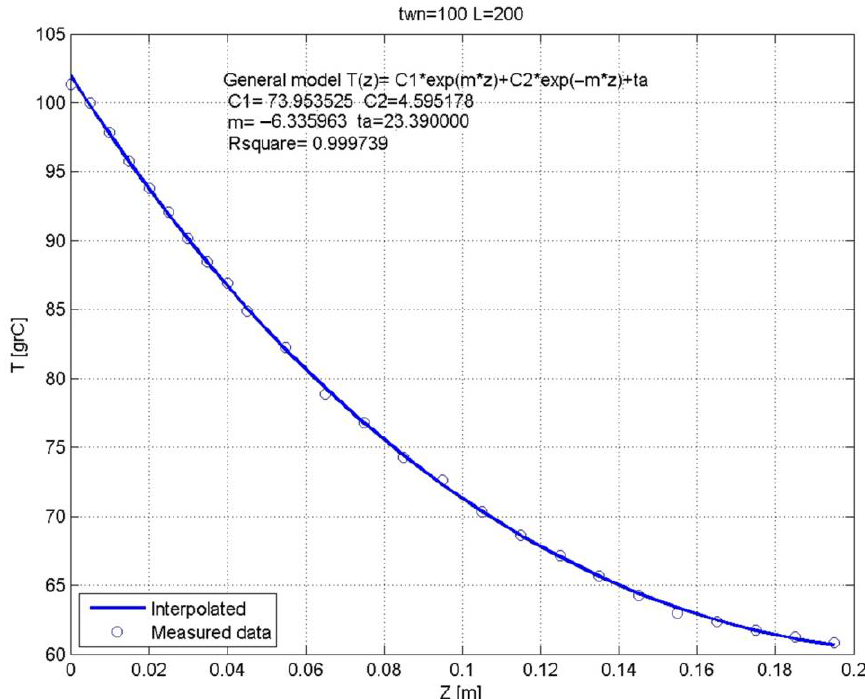
Figure 6. The “exponential” approach involving LSM (for Equation (2)) compared with the ex- perimentally measured data for t O , n = 100 ◦ C; α g = 90 ◦ .